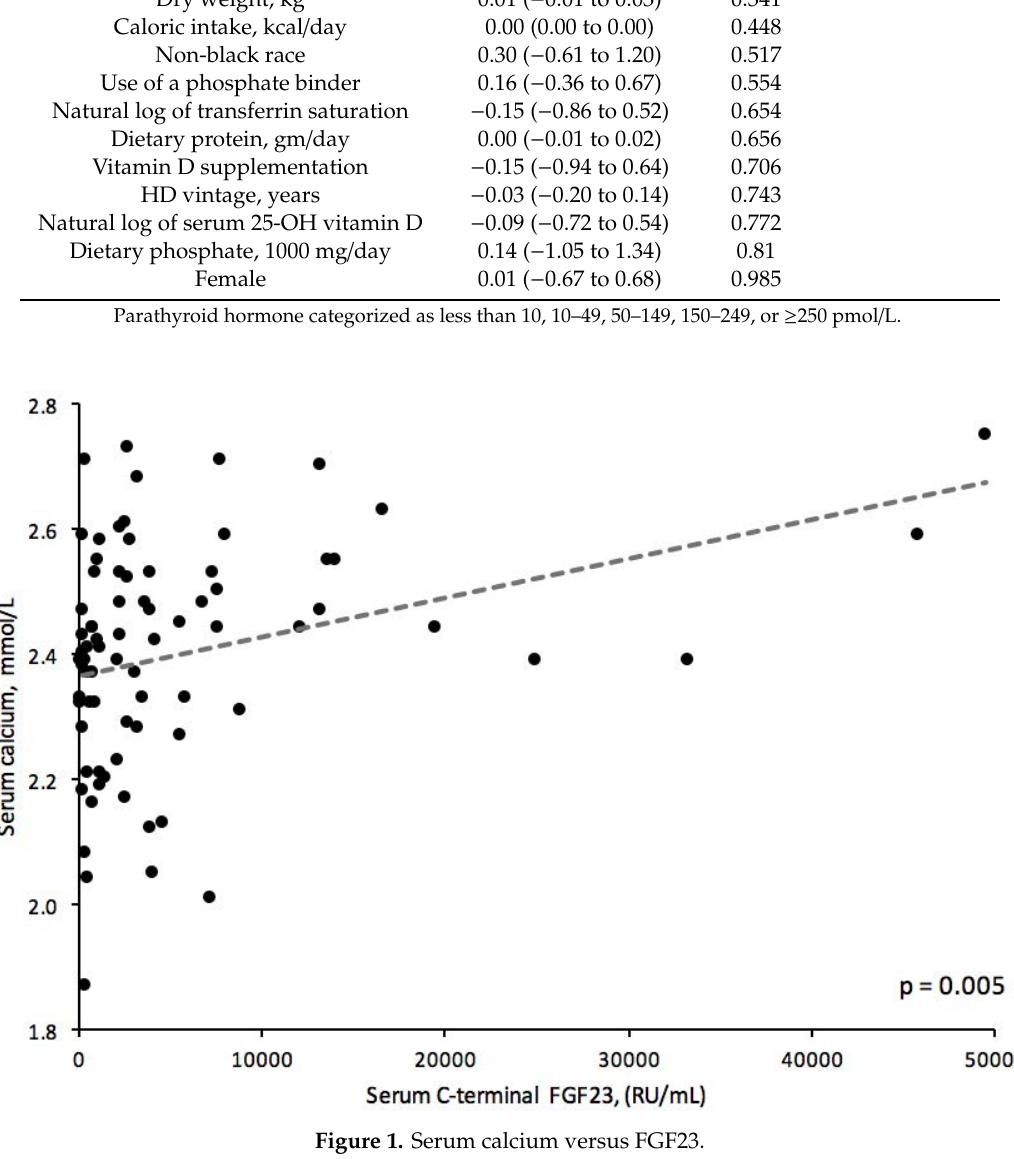
Figure 2. Serum calcium versus the natural log of FGF23. 3.2. Multivariable Models